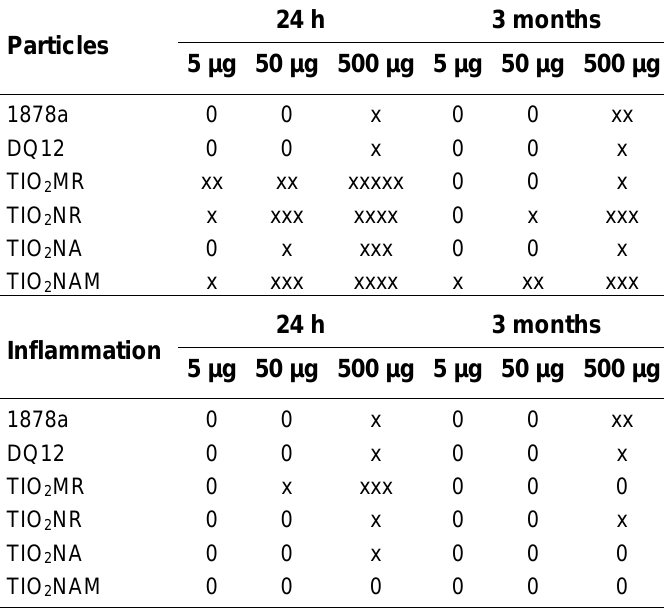
Summary of Histological Findings in the Lungs after a Single Intratracheal Instillation in Mice, Studied after 24 h and 3 Months